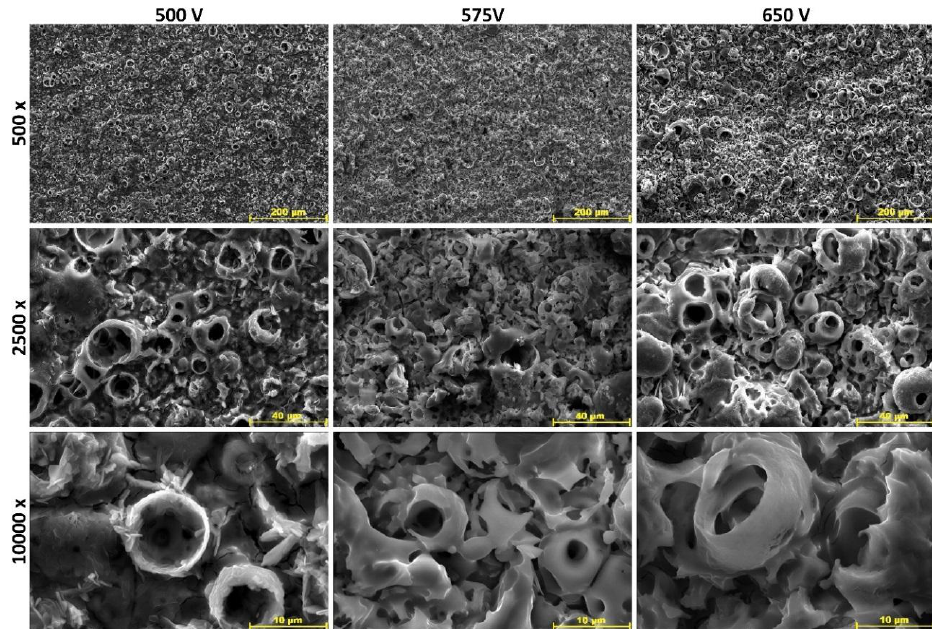
Figure 1. SEM images of coatings formed on Titanium after PEO process at voltages 500 V DC , 575 V DC